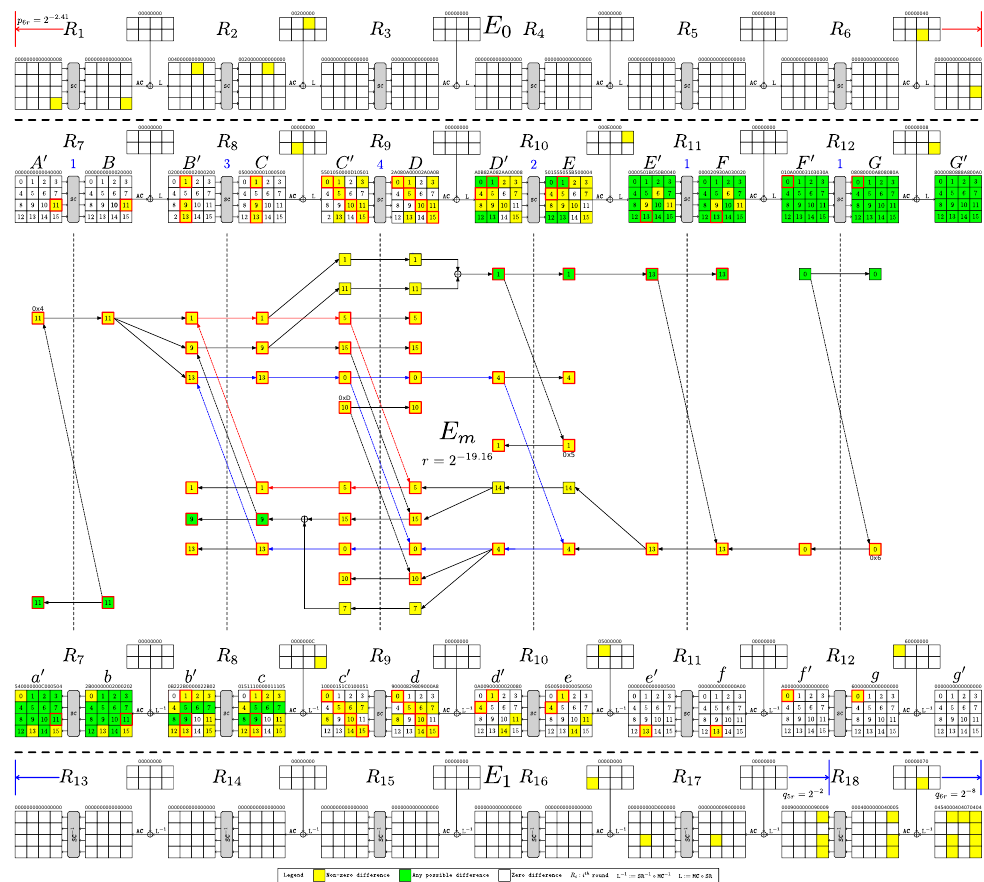
Figure 12: Boomerang distinguisher I for 18 rounds of SKINNY -64-128 with the form 6 + 6 + 6